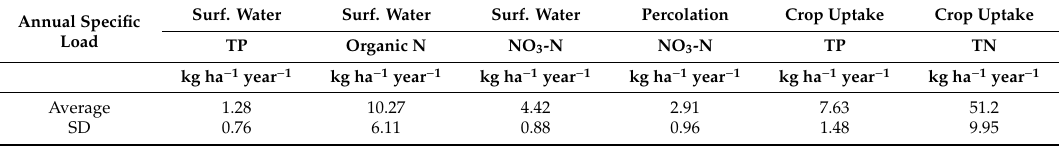
Table 5. Loads input to the river system (TP, organic N, NO 3 -N), NO 3 -N percolation, and crop uptake (TP, TN) simulated by the SWAT model at the basin scale for the current conditions from 1997 to 2006. Surf. Water Annual Specific Load